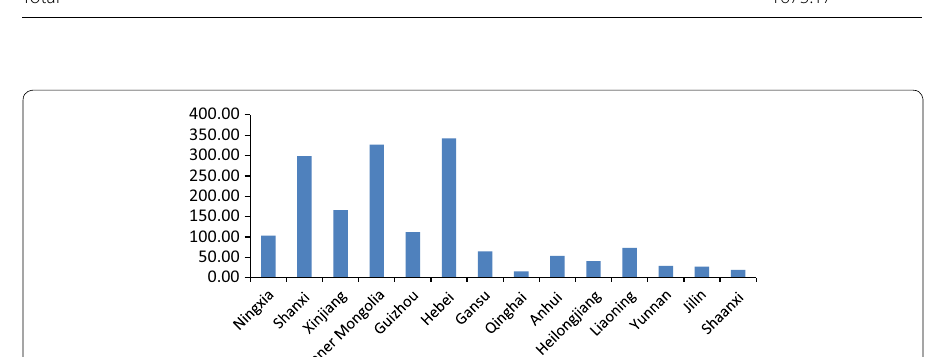
Fig. 5 The potential of CO 2 emission reduction in different